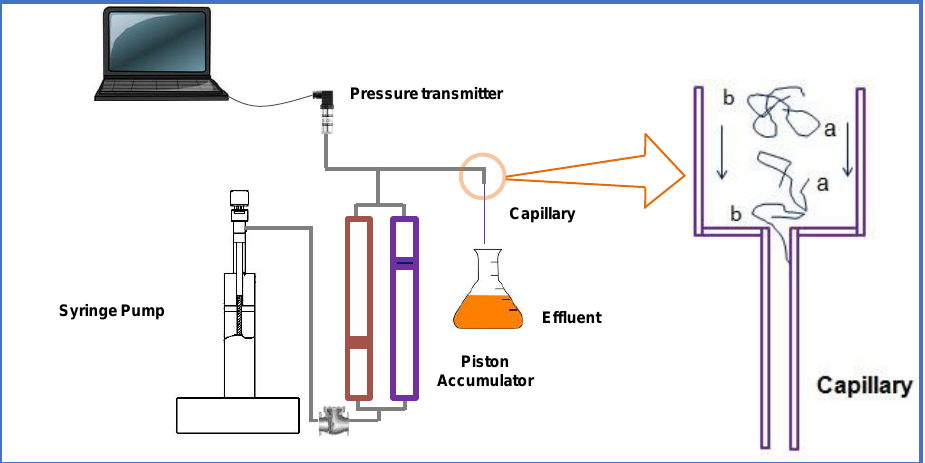
Figure 2. Schematic representation of ( left ) mechanical stability test set-up ( right ) flow of polymer solution through the capillary.